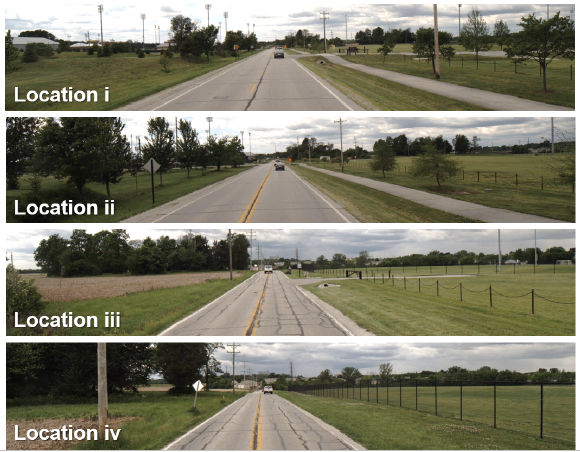
Figure 2: Study site and cross-section